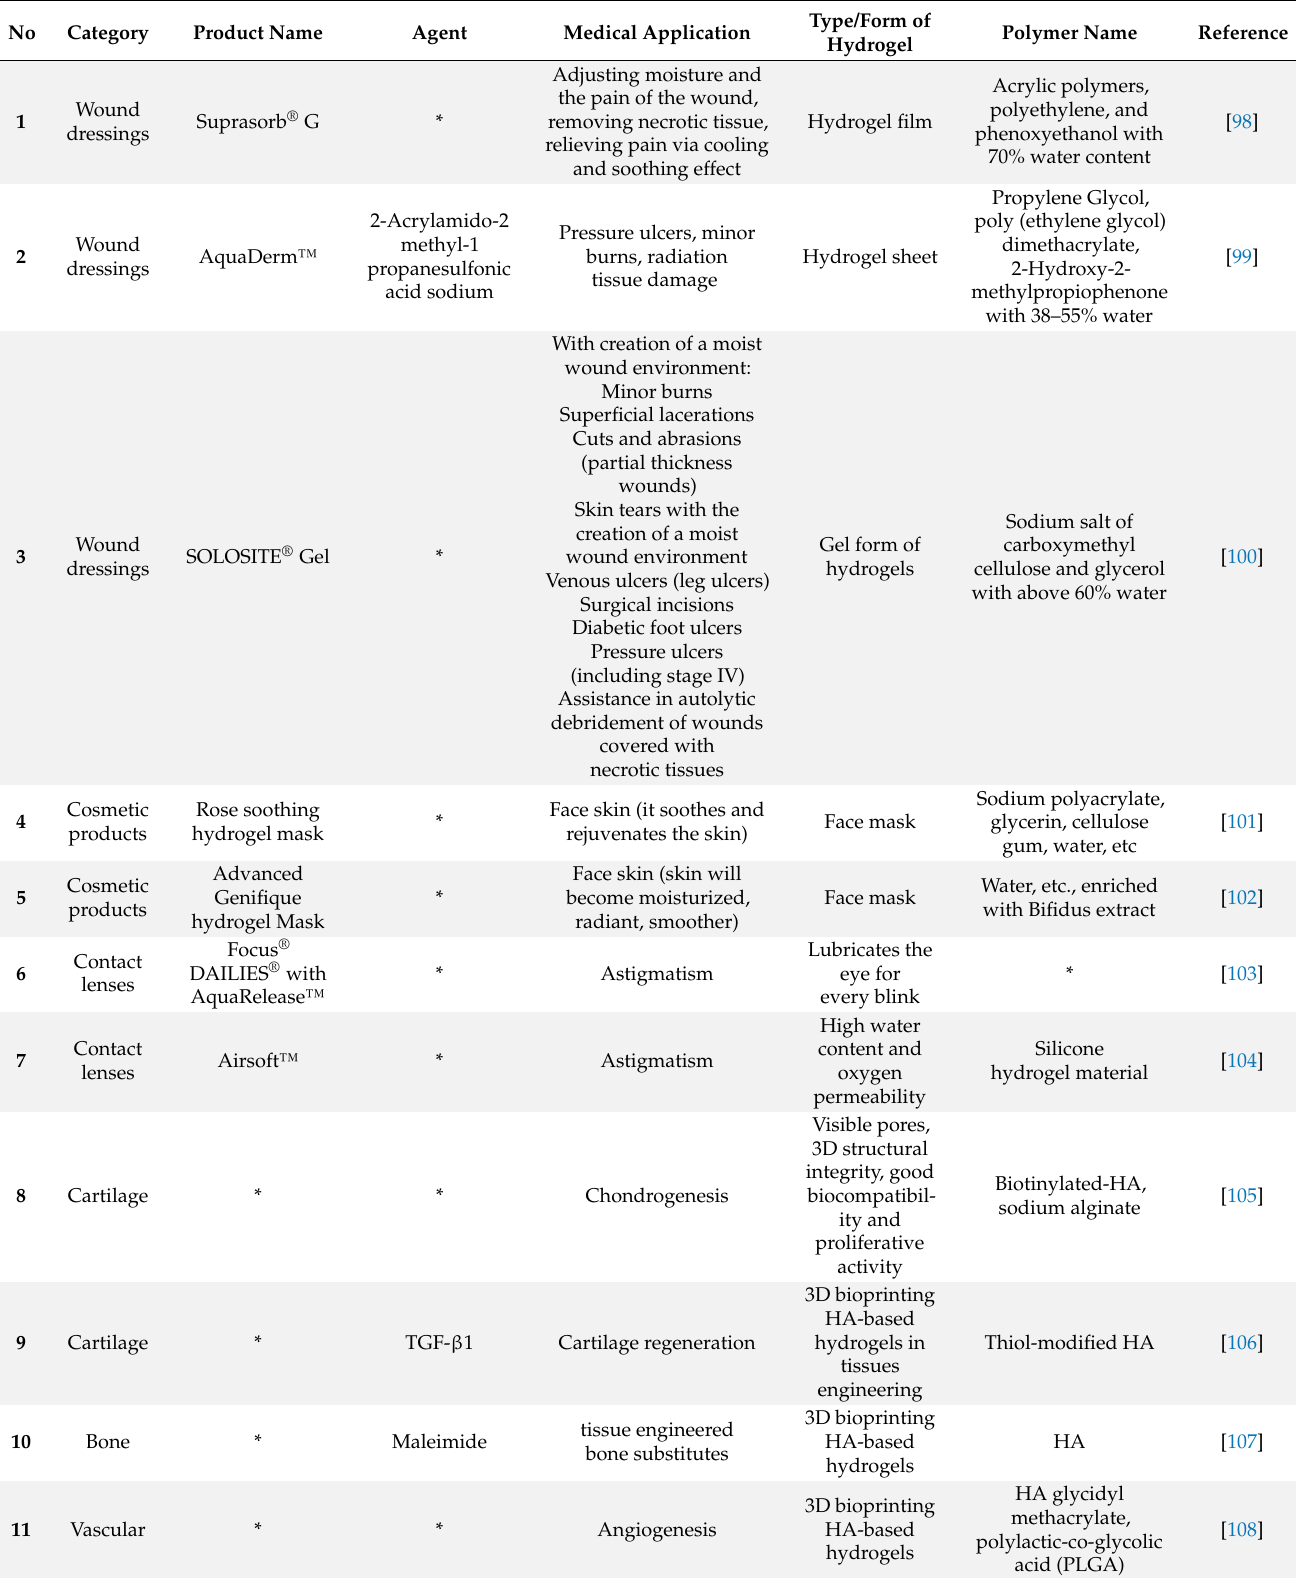
Table 1. Represents the hydrogel-based products in the biomedical